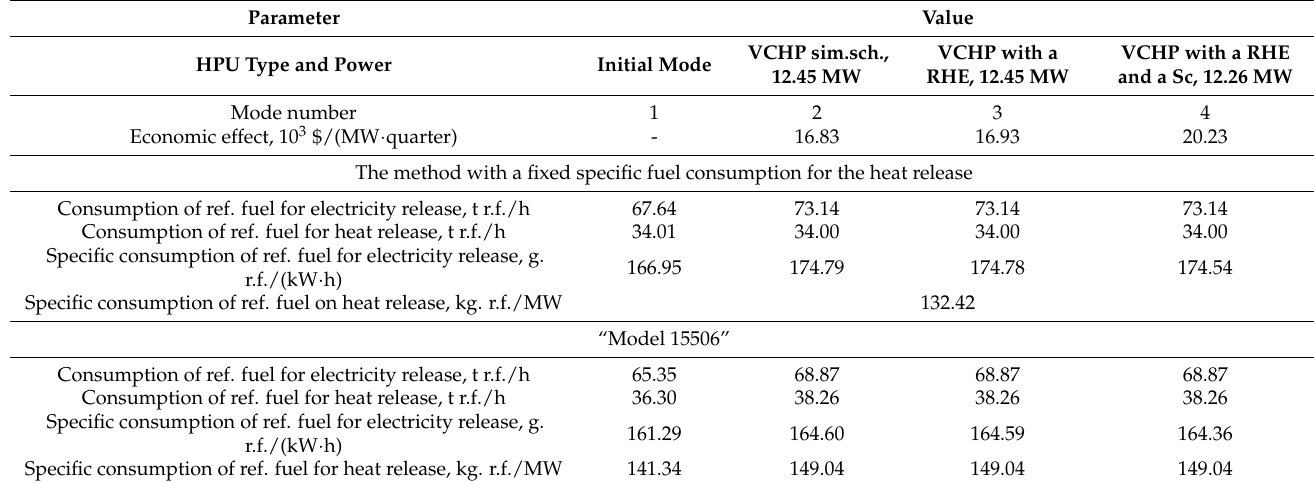
Table 13. Summer modes simulation results of using VCHPs for cooling the intake